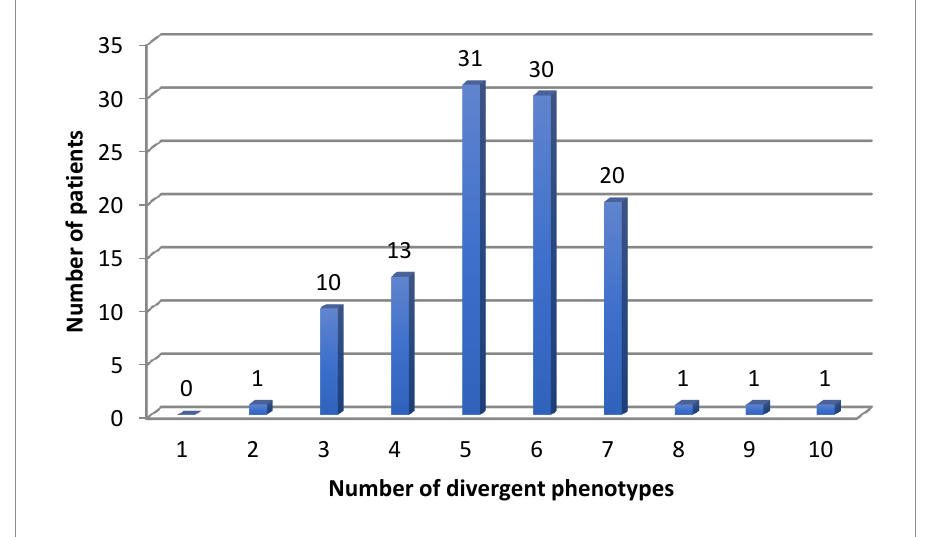
Figure 3. Number of divergent phenotypes in 108 patients for 12 pharmacokinetic genes.